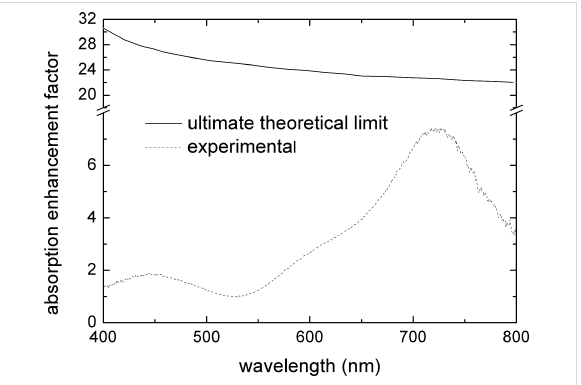
Figure 3: Spectrum of the experimentally determined absorption enhancement factor γ ( λ ) (dotted line) together with the theoretical maximum value (continuous